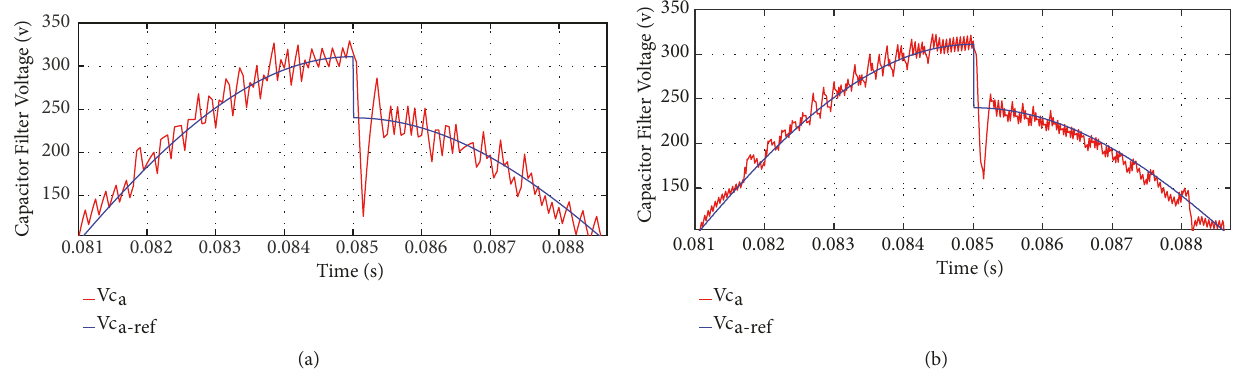
Figure 7: Simulation waveform of capacitor filter voltage (phase a) at the sampling time 𝑇 𝑠𝑝 = 50 𝜇 s for two different voltage levels: (a) the conventional MPVC, (b) the proposed